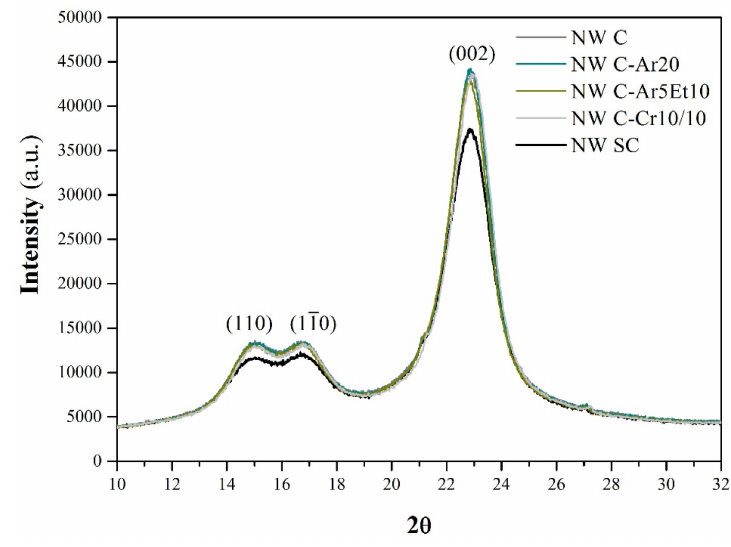
Figure 11. X-ray diffraction patterns of some selected treated and the untreated